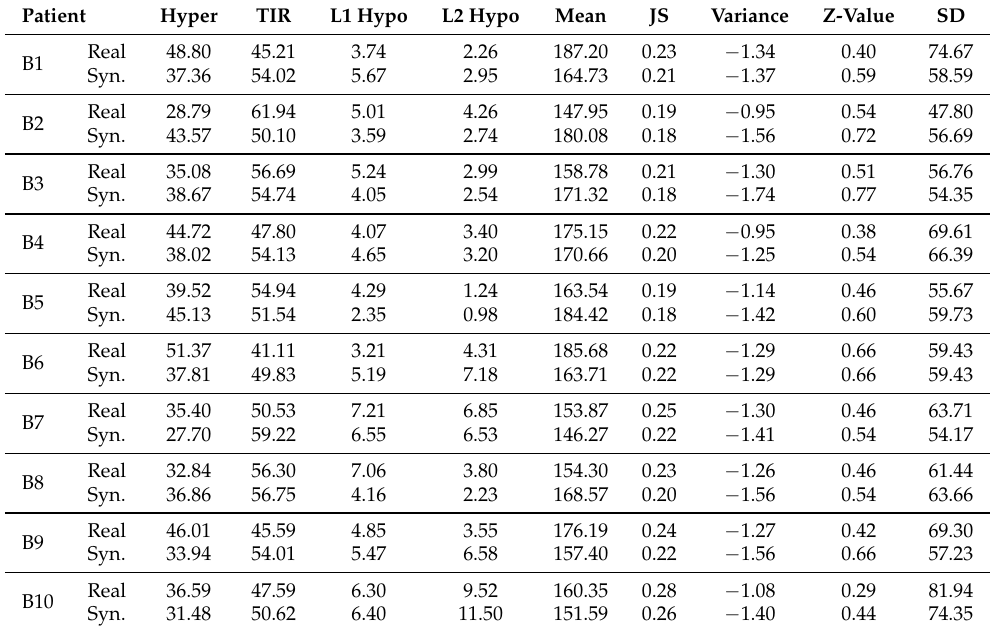
Table 5. Results obtained by comparing real and synthetic data for patients in the Barcelona cohort. All p -values have been accepted. as they pass the acceptance threshold of